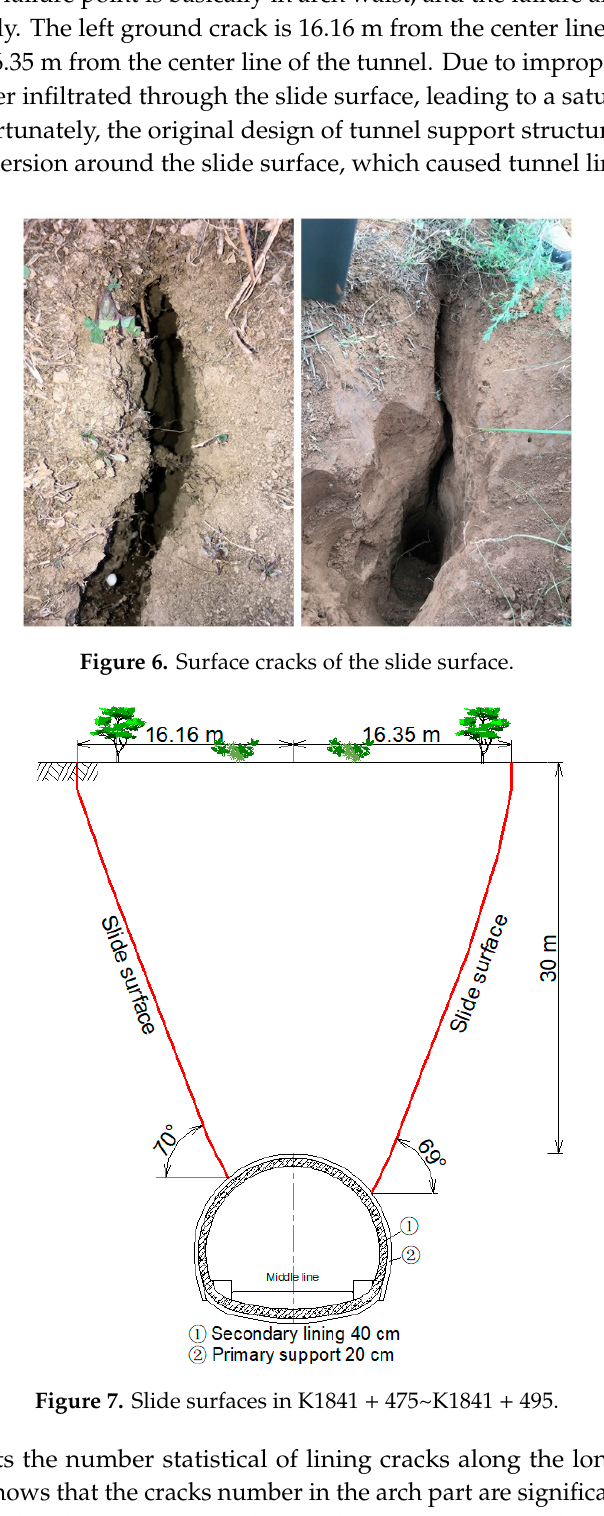
( b ) Figure 8. Statistical graphs of lining cracks number (accumulation per 100 m): ( a ) cracks in arch part and side wall; ( b ) transverse and longitudinal cracks.